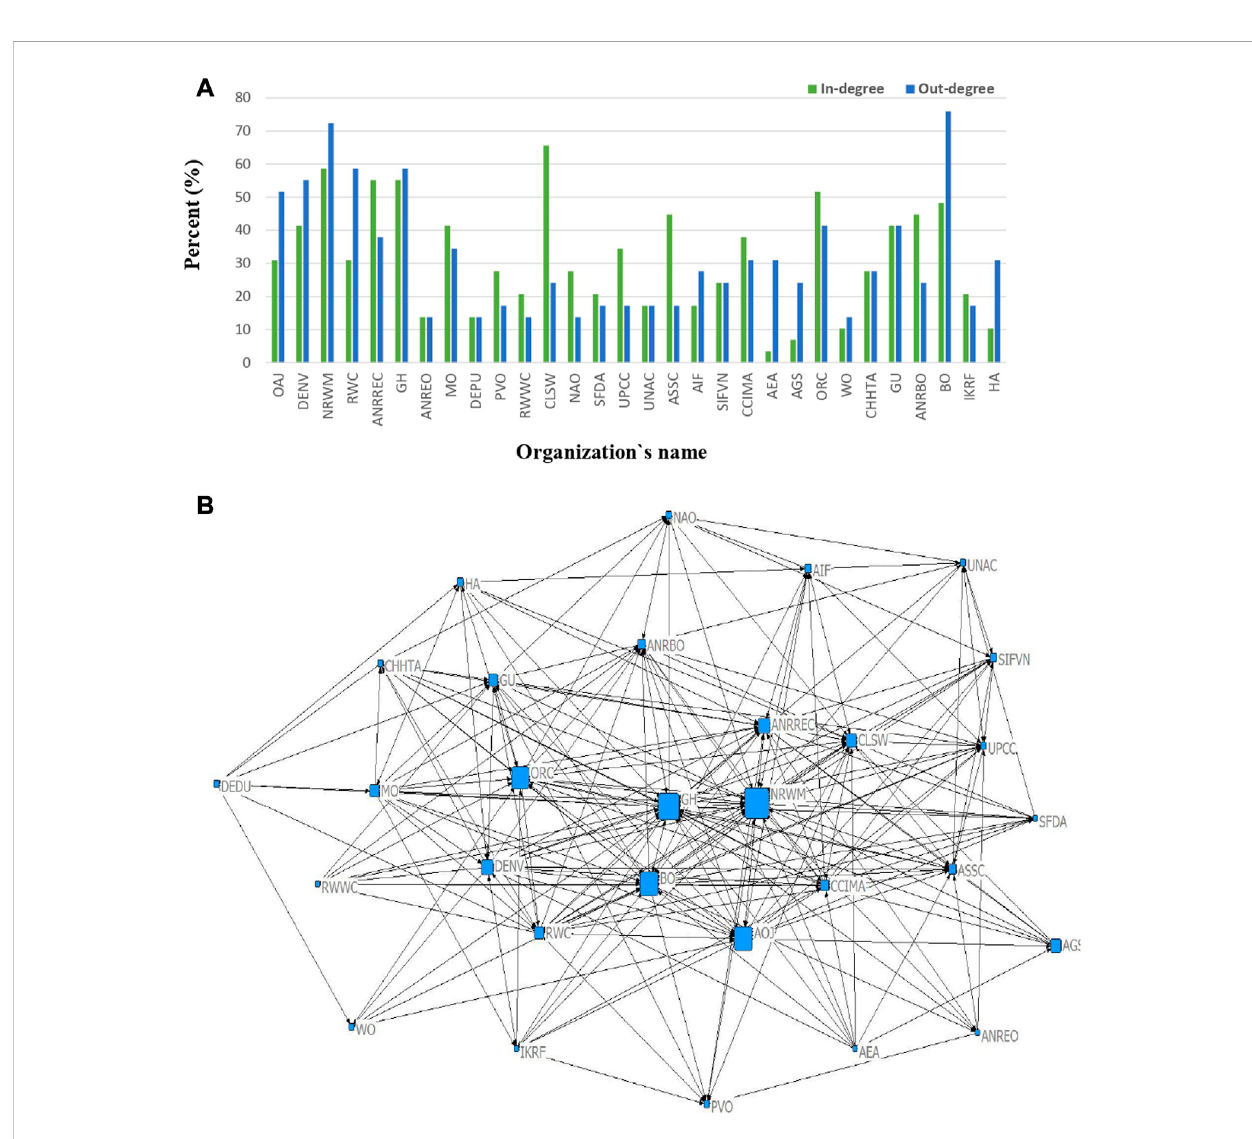
FIGURE 2 SNA results of Information Exchange network (A) In-degree and out-degree centrality (B) Between centrality ( Larger size indicates higher between centrality